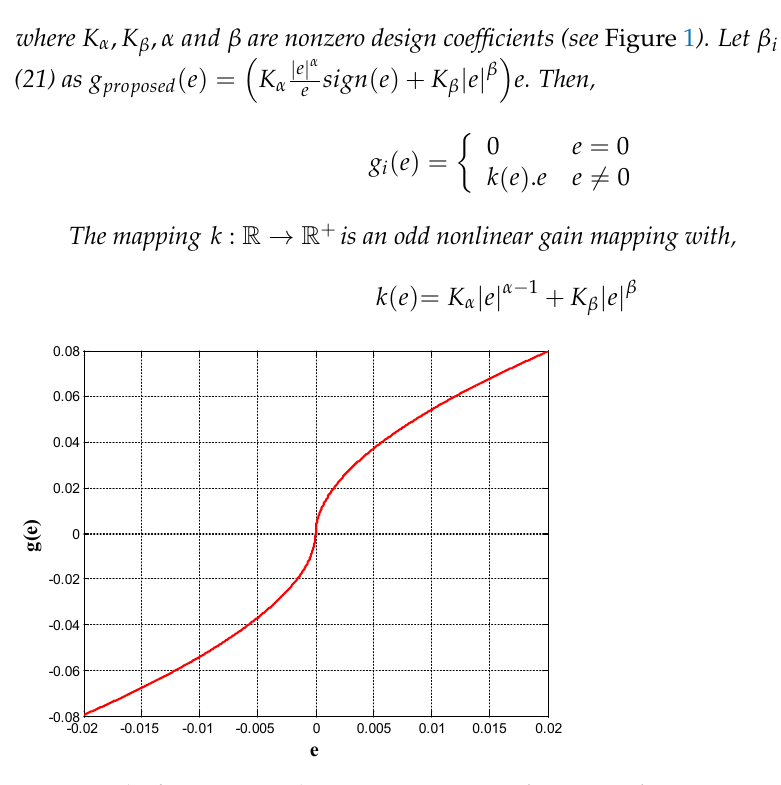
. Figure 1. The function (cid:103) with β = 0.334, α = 0.533, k β = 0.543, k α =